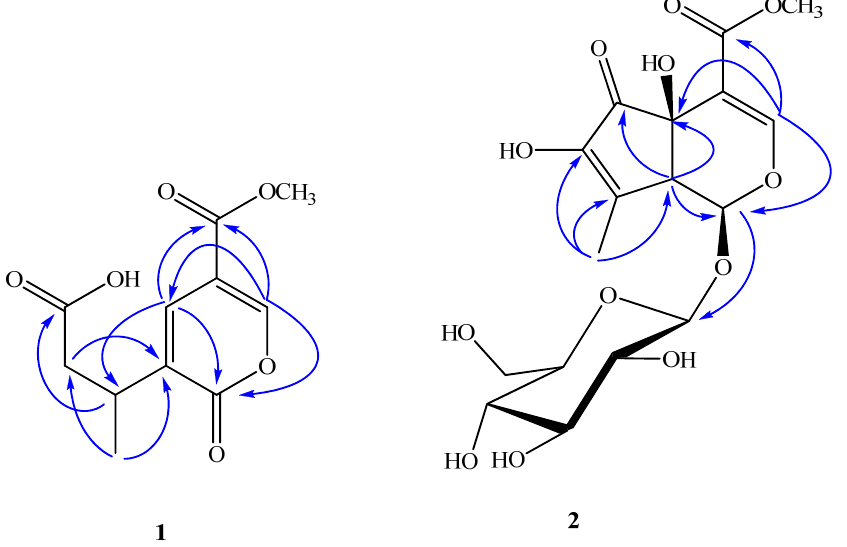
Figure 2. The key HMBC (H → C) correlations of compounds 1 and 2